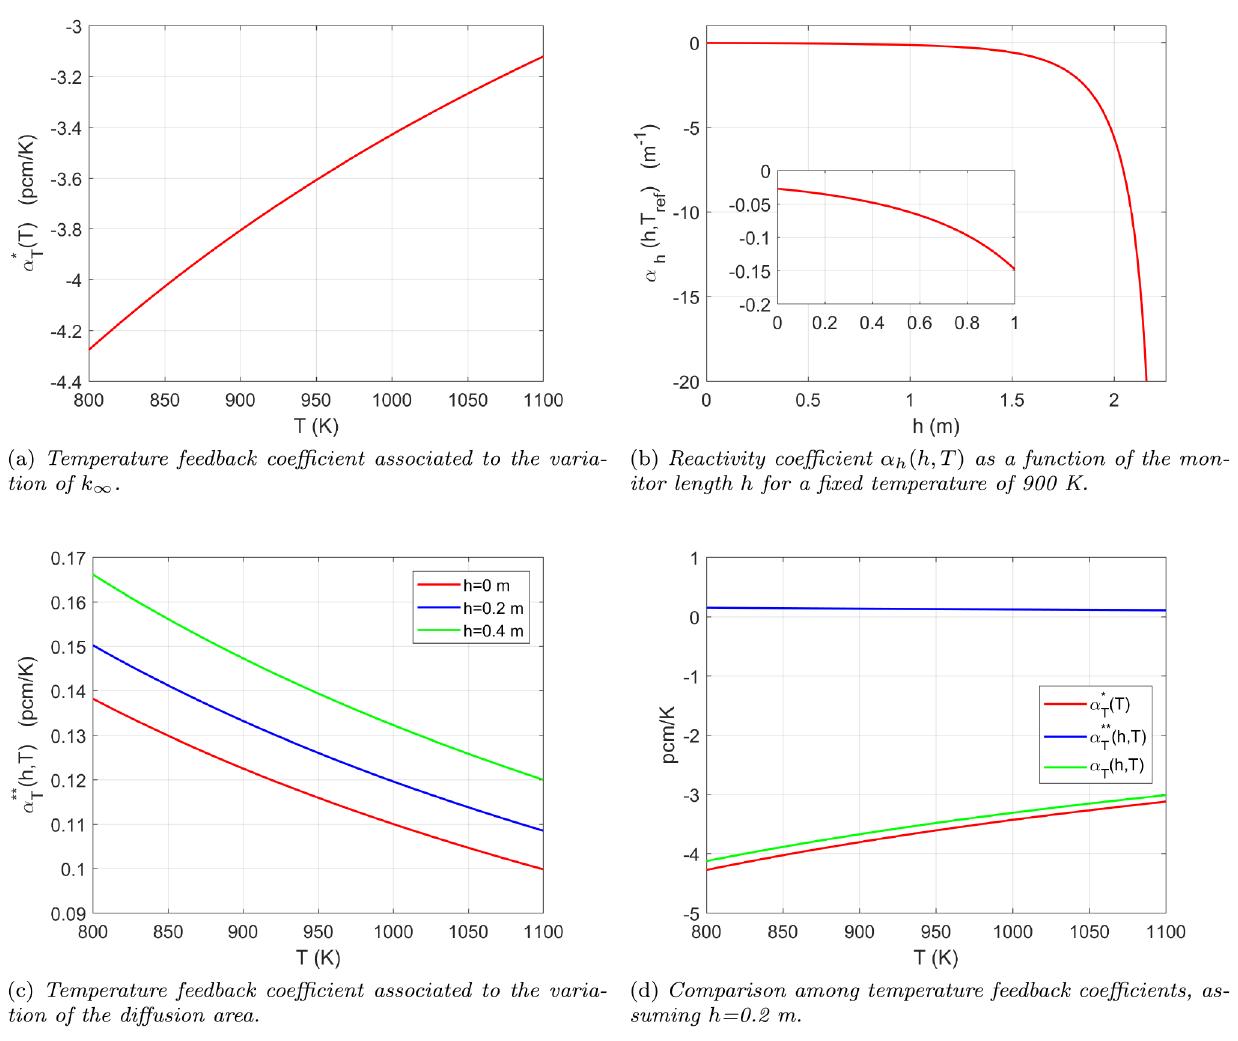
( h, T ) depends also on the monitor T